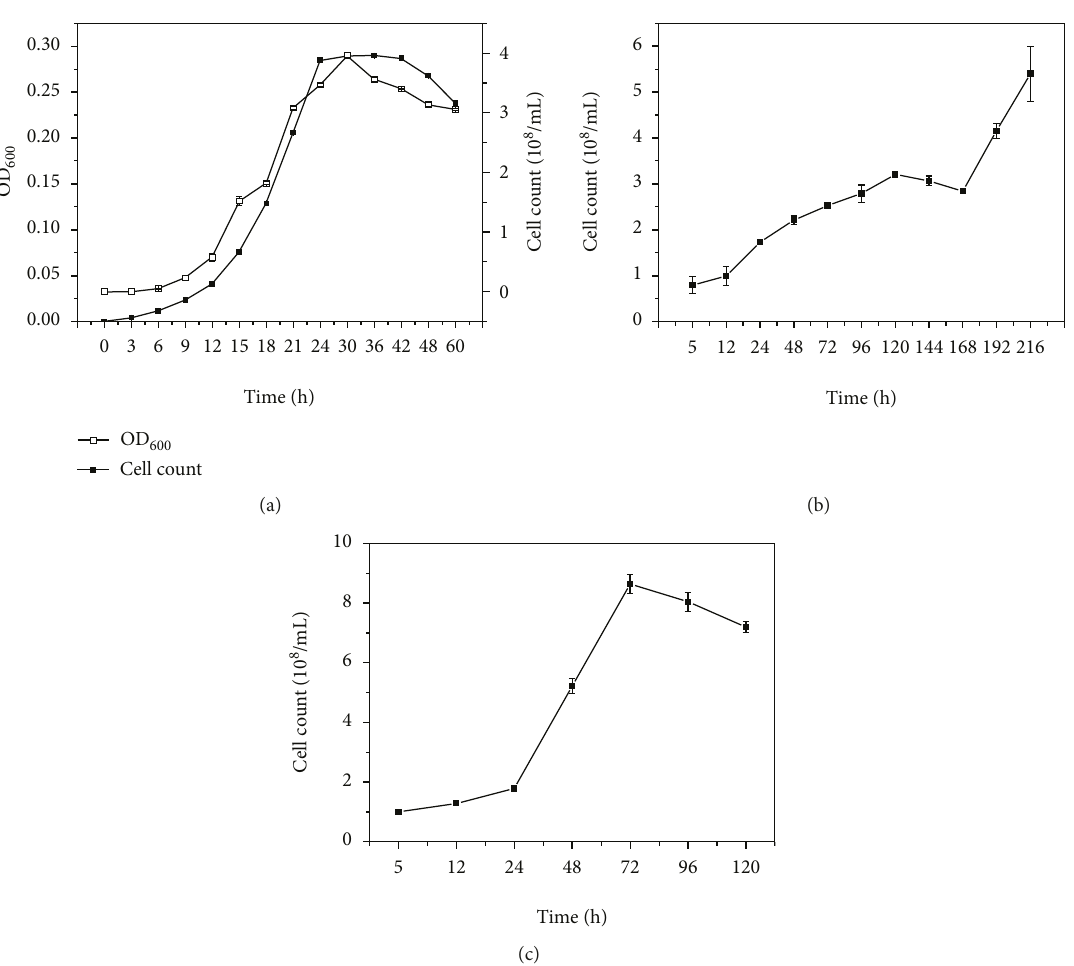
Figure 1: The growth features of strain DM2 in di ff erent medium. (a) Growth curve in LB medium. (b) Growth curve in MM medium with the mixture of alkanes (C :C : C = 1 :1:1) as the sole carbon source. (c) Growth curve in MM medium with 2% petroleum as the sole 15 12 14 carbon